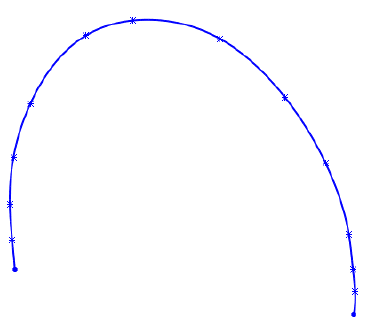
Figure 6. Cross-section line.